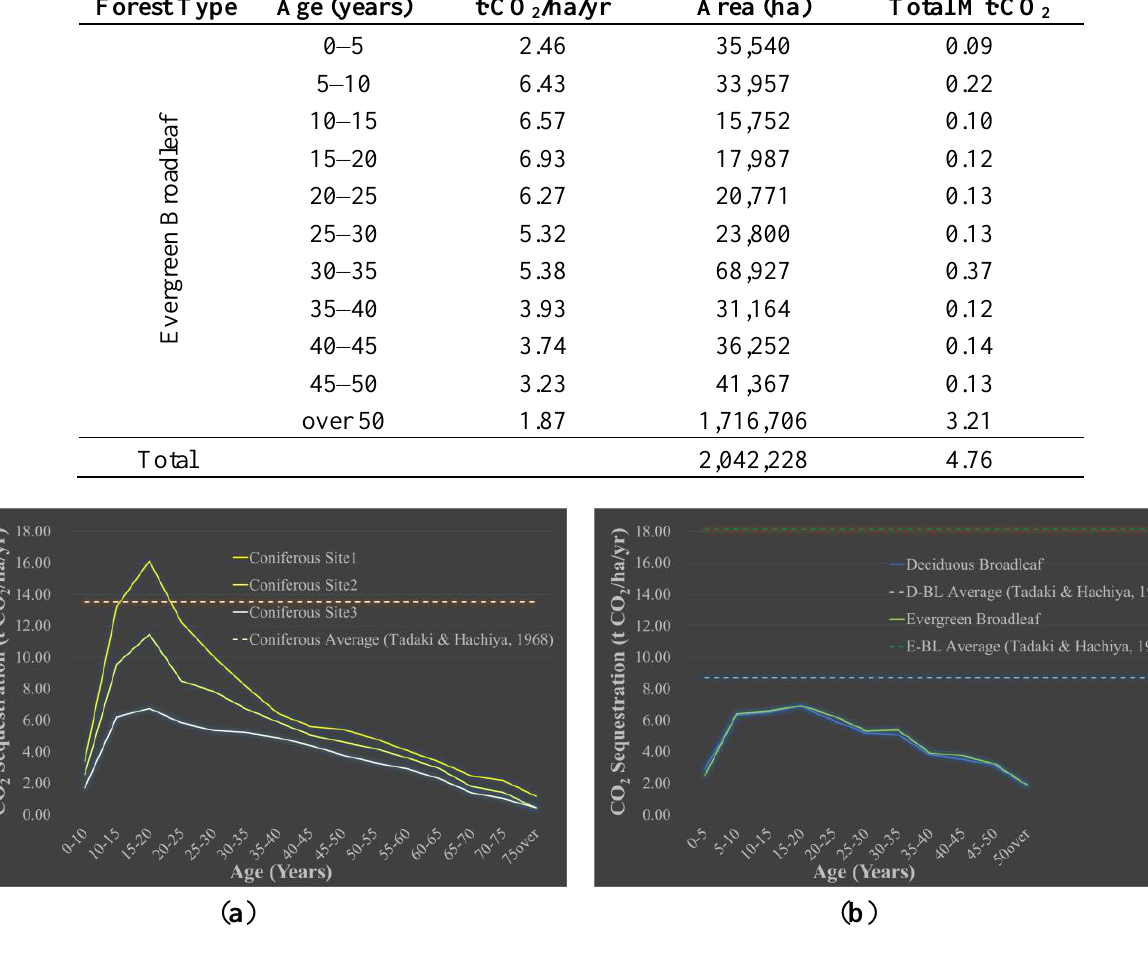
Figure 13. Trend of CO 2 values by tree age classes for ( a ) coniferous and ( b ) deciduous/evergreen broadleaf